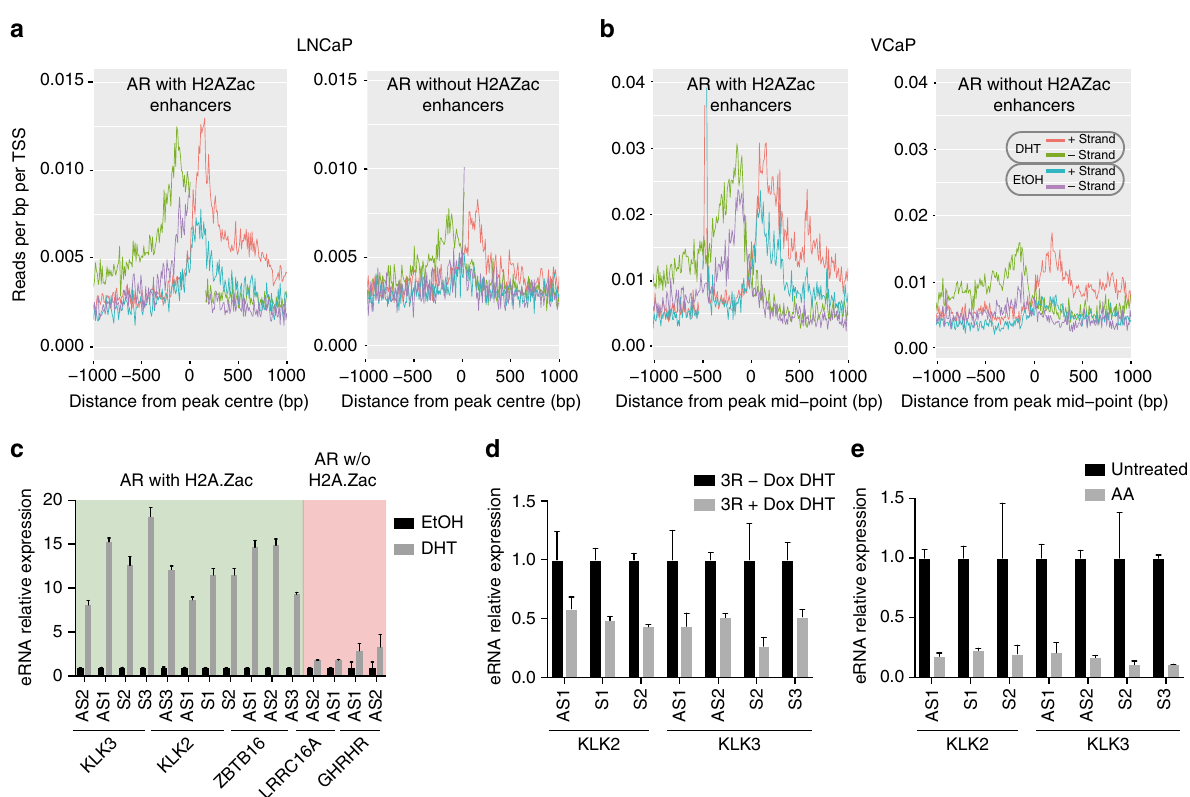
Fig. 8 H2A.Zac is involved in androgen-dependent eRNA expression. Bidirectional histograms (+and – strands) of eRNA pro fi le from GROseq data around AR enhancers during starvation (EtOH) and after DHT treatment (DHT) in the androgen responsive prostate cancer cell lines LNCaP a and VCaP b . AR ChromHMM-de fi ned active enhancers were split into with/without H2AZac and centered on AR peaks as per Fig. 6a, obtaining 1309 and 808 overlaps for AR-enhancers with H2A.Zac and 923 and 1264 overlaps for AR-enhancers without H2A.Zac in LNCaP and VCaP, respectively. Note, four replicates were done for LNCaP GROseq and two replicates for VCaP GROseq, these plots represents one representative replicate. c Real Time qPCR for androgen- responsive eRNA expression in LNCaP cells during starvation (EtOH) or 16 h of DHT treatment (DHT) of representative examples from AR active enhancers fl anked by H2A.Zac-nucleosomes (AR with H2A.Zac, green background) or not fl anked (AR w/o H2A.Zac, red background) (see Fig. 7b). Data is presented as the fold change in eRNA expression normalized to the expression level in EtOH condition ( N = 3). d Real Time qPCR for androgen- responsive eRNA expression of representative eRNAs at AR enhancers fl anked by H2A.Zac ( KLK2 and KLK3 eRNAs, (Fig. 7b) in 3R cells during 16 h of DHT treatment (DHT) and daily Doxycycline (Dox) stimulation (+) or non stimulation ( − ). Data is shown as the fold change in eRNA expression normalized to the expression level in – Dox DHT condition ( N = 2). e LNCaP cells were either untreated or treated (AA) with Anacardic Acid at 90 µ M for 48 h ( N = 2). eRNA expression levels of the AR-enhancer for KLK2 and KLK3 genes were measured by Real Time qPCR. Data are shown as the fold change in eRNA expression normalized to the expression level in the Untreated condition. For the eRNA Real time qPCR several primers were used per eRNA at regions around 200 – 1000 bp from the center of the AR binding site on the sense (S) or anti-sense strand (AS) (See Supplementary Table 4 for primer description). All error bars are shown